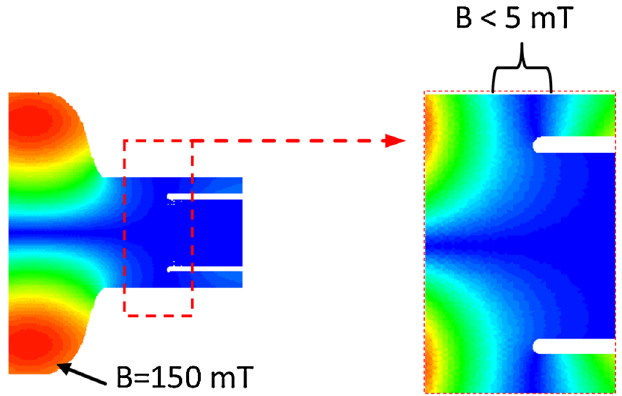
FIG. 2. (Color) B -field pattern in the beam tube at the joint.